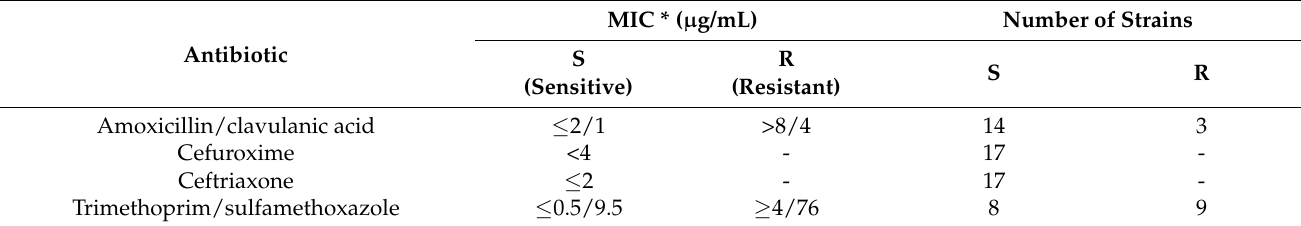
Table 4. Antibiotic resistance of Haemophilus influenzae strains.